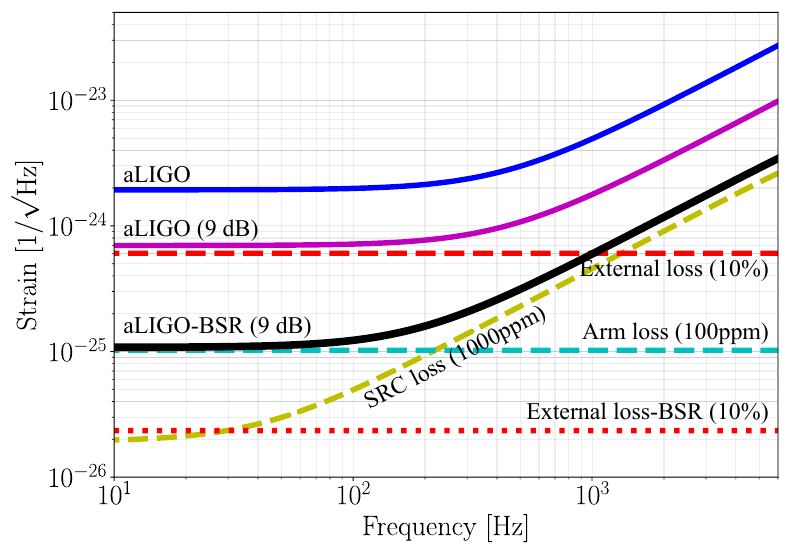
Figure 1. This figure shows the noise spectral densities of optical losses and the shot noise limited sensitivity with parameters from aLIGO [7]. We assumed 1000ppm signal-recycling cavity (SRC) loss, 100ppm arm cavity loss and 10% external loss. The blue line illustrates the shot noise of aLIGO. The purple line is with 9dB observed squeezing (15dB squeezing in the arm cavities). The black line ∼ illustrates the resulting shot noise of the aLIGO configuration with the BSR scheme discussed in this work. It approaches the SRC loss limit at high frequencies and arm cavity loss limit at low